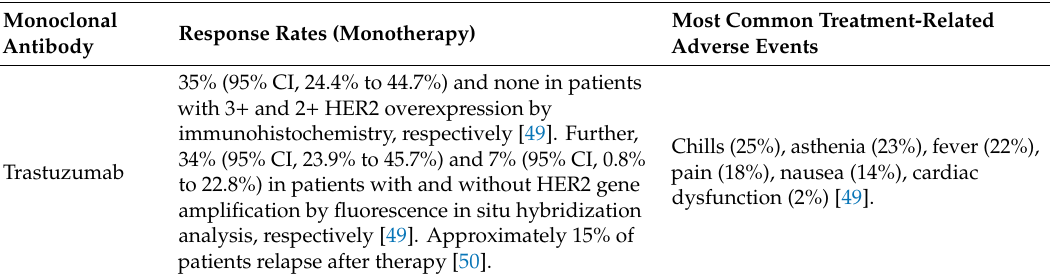
Table 4. Approved humanized monoclonal antibodies for breast cancer